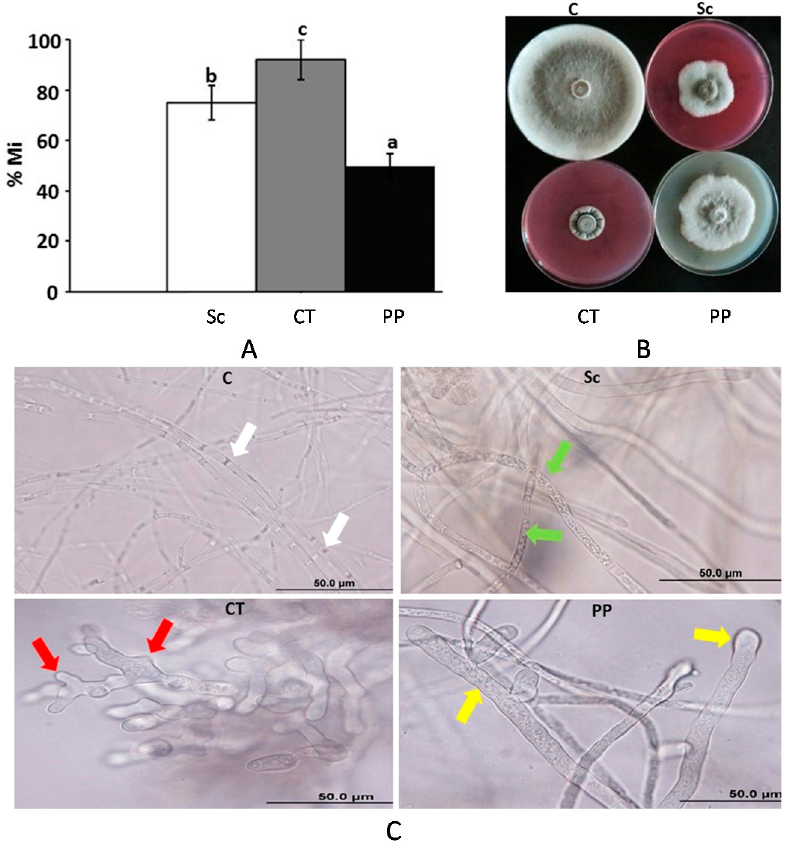
Figure 5. Efficacy of fungicides against L. theobromae . ( A ) Growth inhibition rate (% Mi) of L. theobromae using 250 ppm of the fungicides after 10 days. Values with different letters are significantly different from each other at p < 0.05; ( B ) the effect of fungicides (250 ppm) on in vitro mycelial growth; and ( C ) abnormalities in hyphal morphology, septum formation, and cytoplasmic contents of L. theobromae , following fungicide treatments, compared to control. White arrows indicate normal septate hyphal growth; green arrows indicate formation of non-septate hyphal formation and cytoplasmic coagulation; red arrows indicate hyphal swellings and branch deformation; yellow arrows indicate hyphal swellings and cytoplasmic coagulation. C, control (no fungicide); Sc, Score ® ; CT, Cidely ® Top; PP, Penthiopyrad ® .